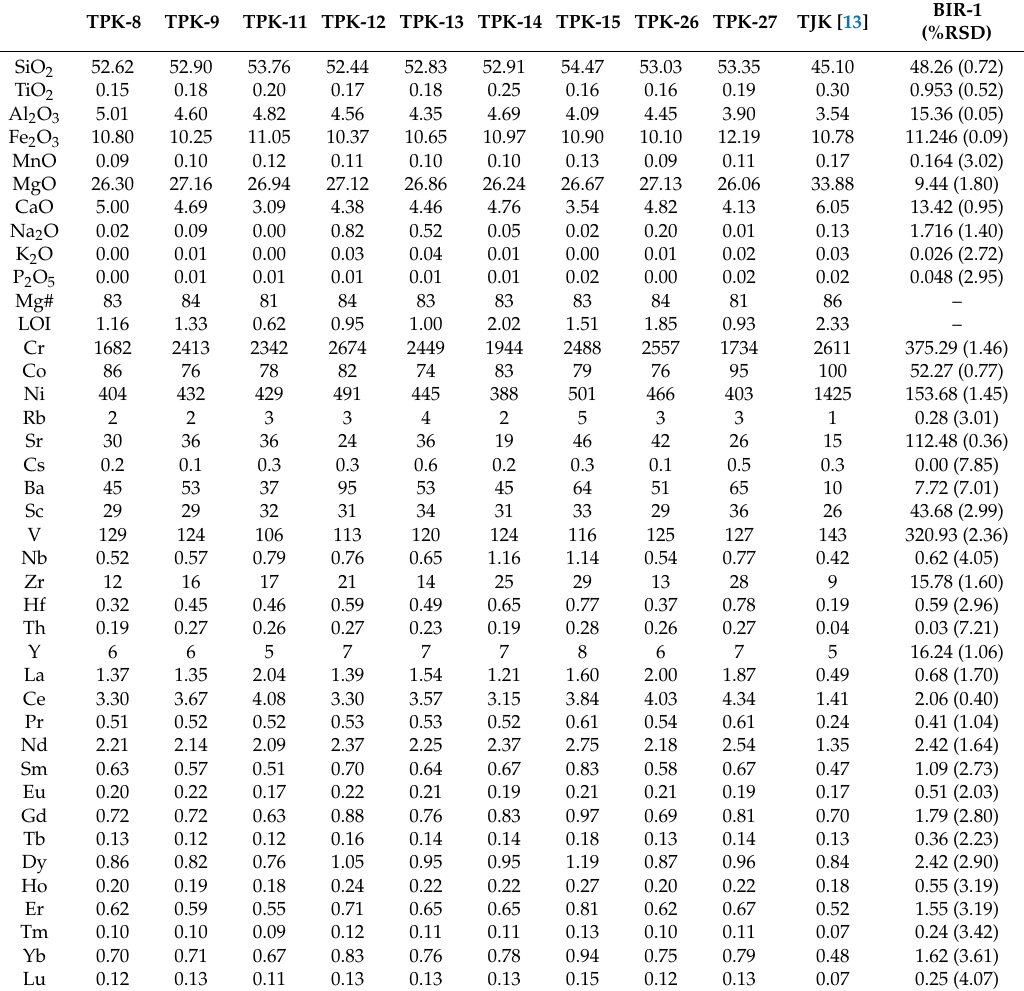
Table 4. Bulk-rock major (wt. %) and trace element (ppm) composition of Holenarsipur boninites and Kadihalli komatiite, western Dharwar craton, India. determined values for BIR-1 are also